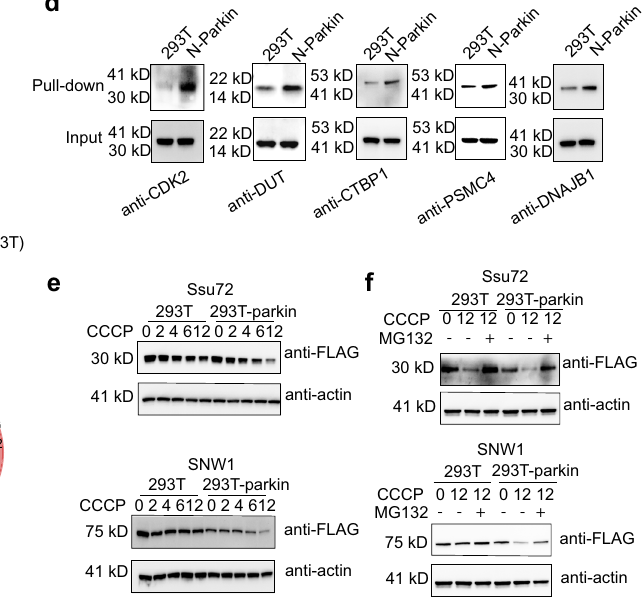
Fig.5|Substrateidenti fi cationoftheE3ligaseParkin.a VolcanoplotsofParkin- interacting proteins in HEK293T cells with stably expressed miniSOG fused to either the N-terminal or C-terminal of Parkin ( n =3 independent biological experi- ments). A two-sided student ’ s t -test was used in the volcano plot. HEK293T was used as the negative control. Signi fi cantly changed proteins are highlighted in red ( p <0.05and>2-foldionintensitydifference).Relevantproteinsthataresigni fi cant in HEK293T-miniSOG but not in HEK293T are marked in green. b Venn diagram showing overlapping proteins between N-terminal and C-terminal